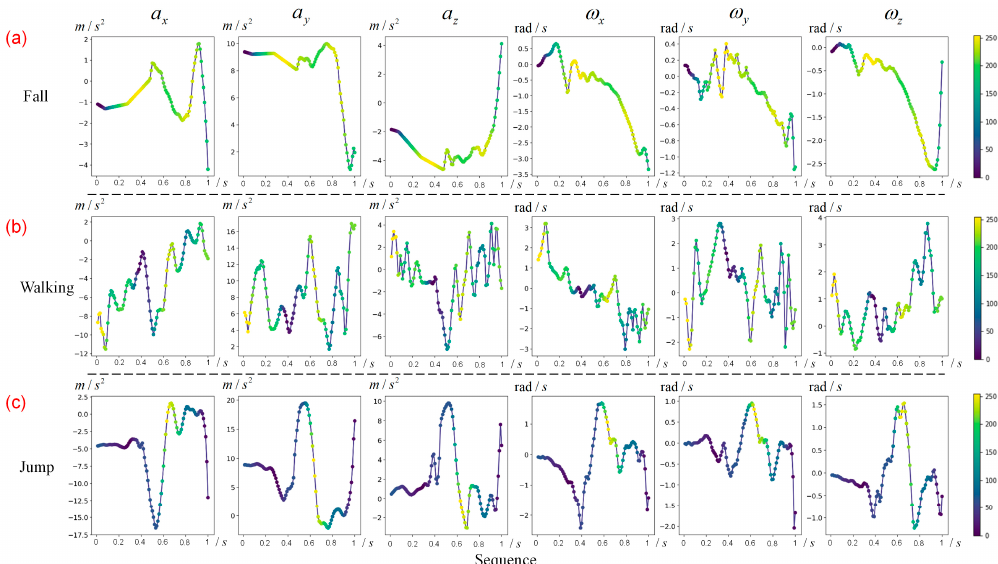
Figure 5. The hot map of four samples of the MobiAct dataset. The color bar indicates the importance of regions in the sequence for classification. a x , a y , and a z represent x-axis, y-axis, and z-axis of acceleration, respectively. ω x , ω y , and ω z represent x-axis, y-axis, and z-axis of angular velocity, respectively. ( a ) One fall sample. ( b ) One walking sample. ( c ) One jump sample.